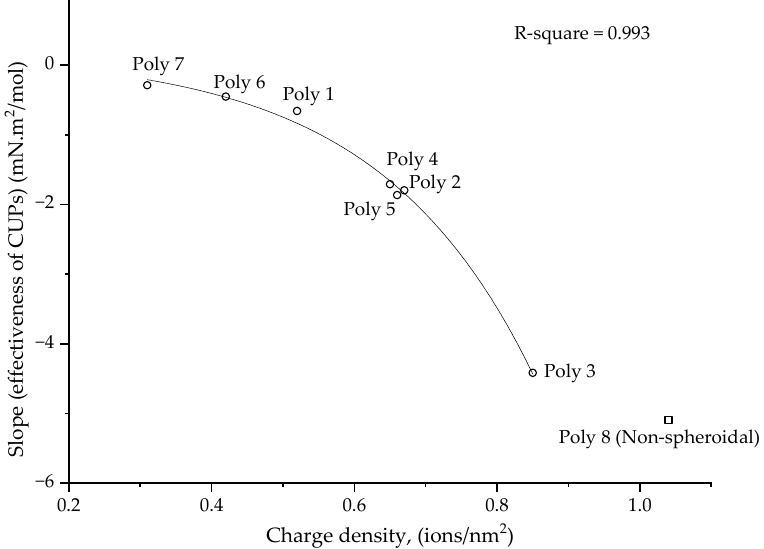
Figure 4. The slope or effectiveness of CUP against the charge density (ions/nm 2 ) of the particles.